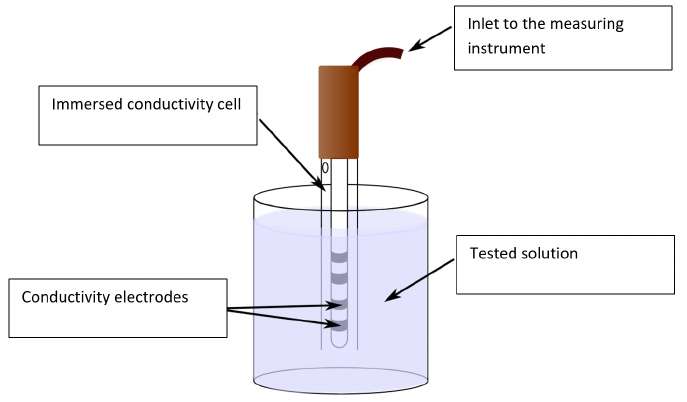
Figure 4. The applied ZU 6985 four-electrode conductivity cell.